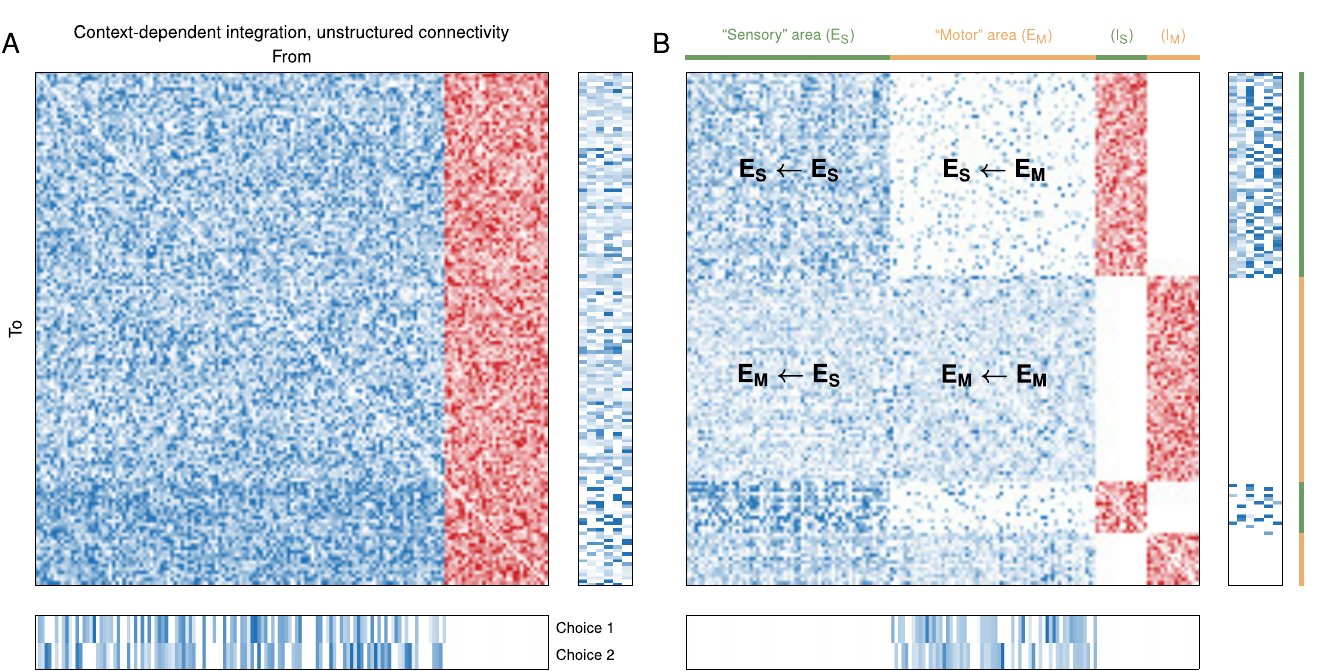
Fig 5. Constraining the connectivity. Connectivity after training for the context-dependent integration task (Fig 4), when the connection matrix is (A) unstructured and (B) structured. Both networks consist of 150 units (120 excitatory, 30 inhibitory). In B the units are divided into two equal-sized “ areas, ” each with a local population of inhibitory units ( I S and I M ) that only project to units in the same area. The “ sensory ” area (green) receives excitatory inputs and sends dense, “ long-range ” excitatory feedforward connections E M E S to the “ motor ” area (orange) from which the outputs are read out. The sensory area receives sparse excitatory feedback projections E S E M from the motor